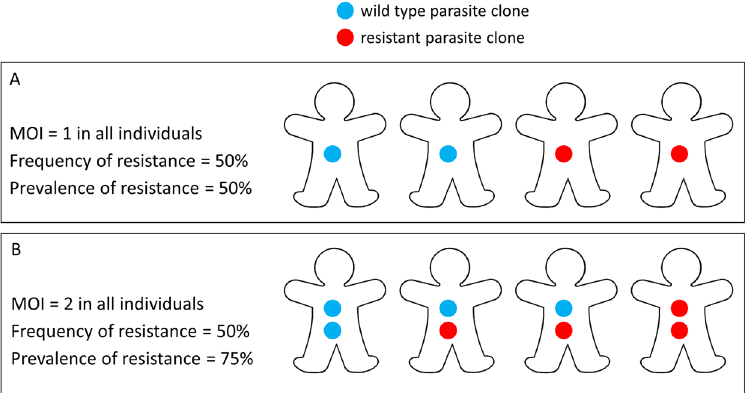
Figure 1. The difference between the prevalence of resistance in the infected human population (% of individuals carrying at least one resistant parasite clone) and the frequency of resistance in the parasite population (% of parasite clones which are resistant). If each individual carries only one parasite clone (a multiplicity of infection (MOI) of 1) ( A ), then the frequency and prevalence of resistance are the same. However in most areas, particularly areas with high malaria transmission intensity, individuals carry multiple parasite clones, so that the frequency and prevalence of resistance are often not the same. For example, if everyone in an area carries 2 parasite clones ( B ), and the frequency of resistance in the parasite population is 50%, then the prevalence of resistance in humans would be 75% if clones are distributed randomly. The prevalence of resistance in humans is almost always higher than the frequency of resistance in the parasite population due to multi-clonal infections. In reality, individuals in a malaria-endemic area carry different numbers of parasite clones (which we allow for in the analyses presented in the Methods and Results